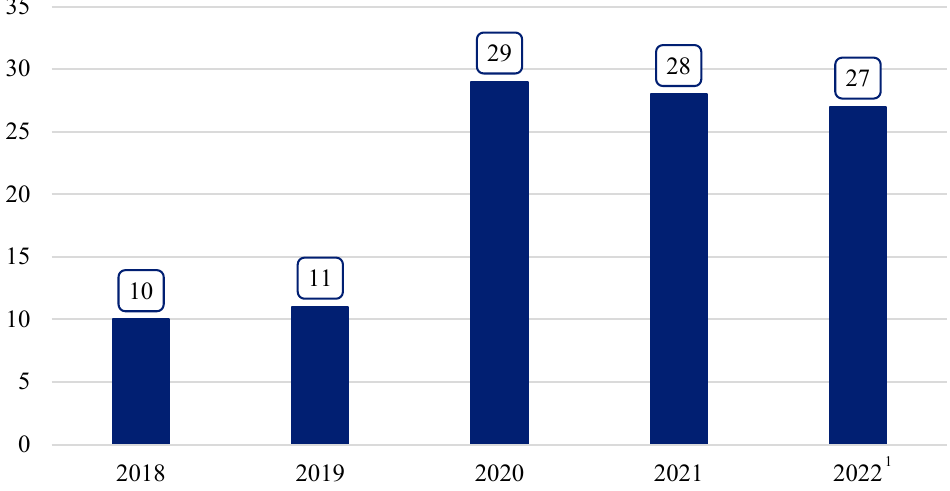
Figure 4. Number of publications for each year. (Chart produced in Microsoft Excel).